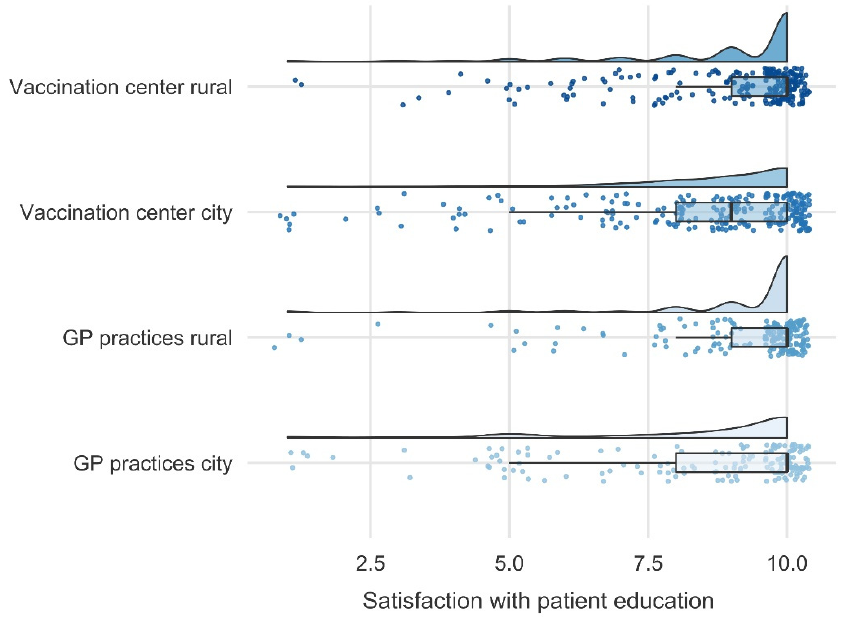
Figure 5. Differences between sites in participants’ overall satisfaction with the patient education